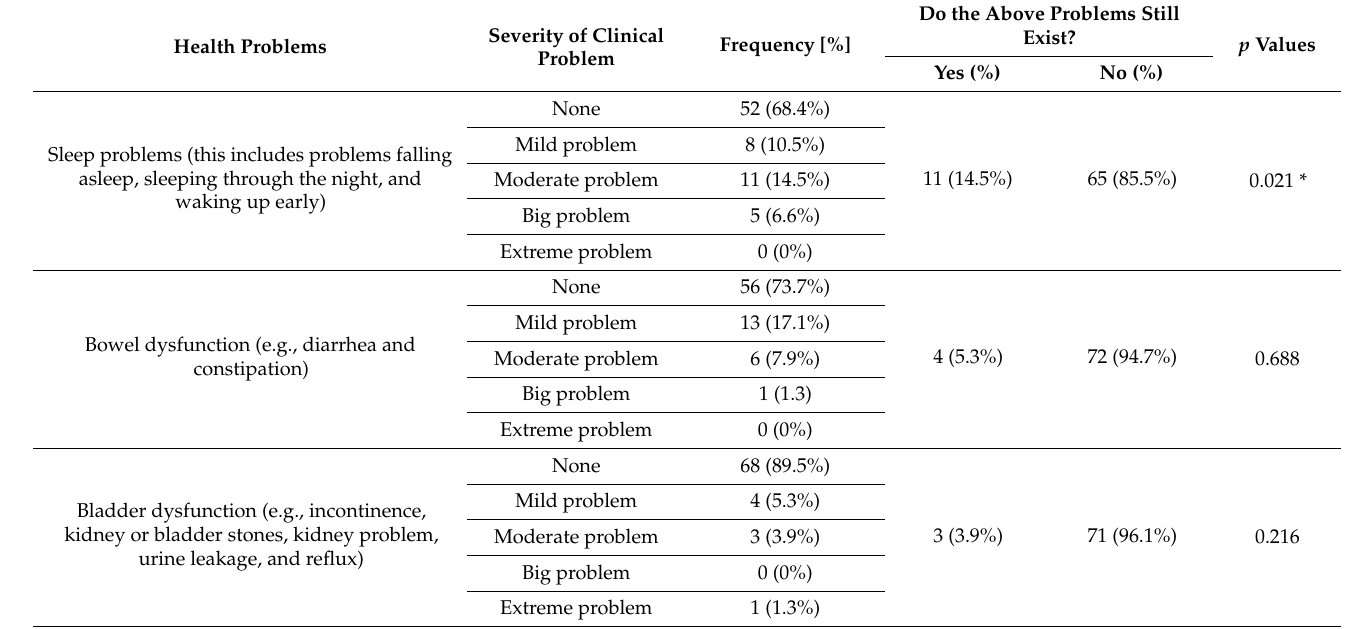
Table 2. Post-COVID-19 clinical status of participants ( n = 76). Results are presented as frequency of responses [%]. Statistical significance was obtained using the Chi-square test (X 2 ). Single or double asterisks represents the statistically significant difference (* p < 0.05; ** p < 0.01) in distribution of responses among study